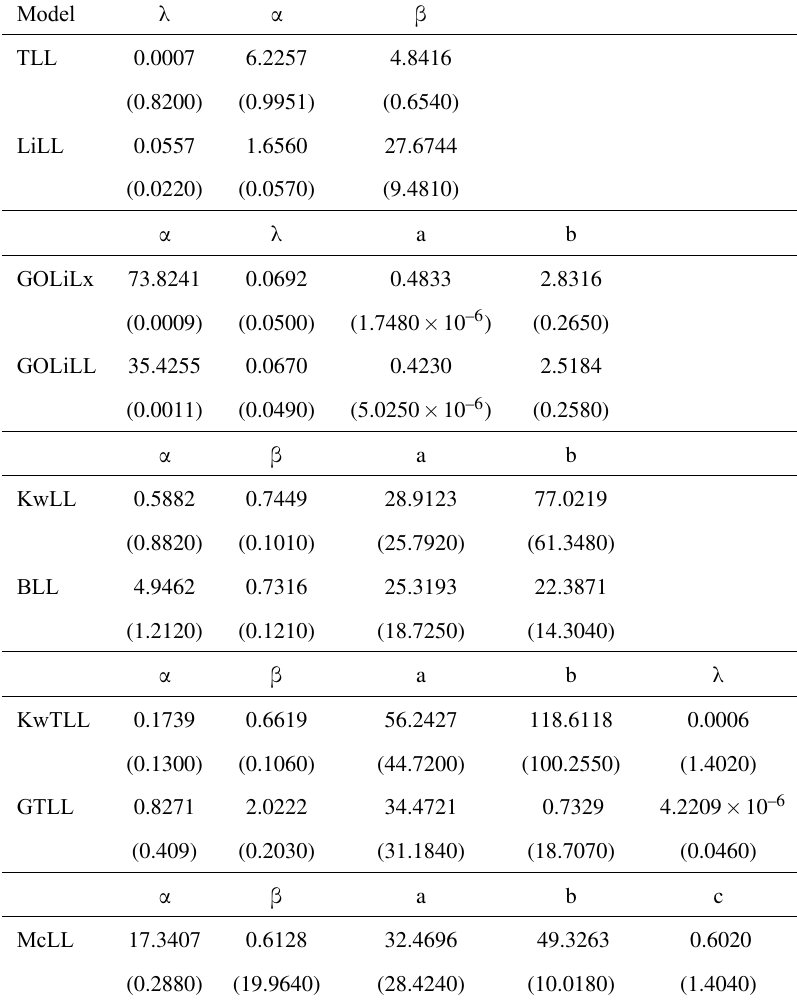
MLEs and their standard errors (in parentheses) for time-to-failure